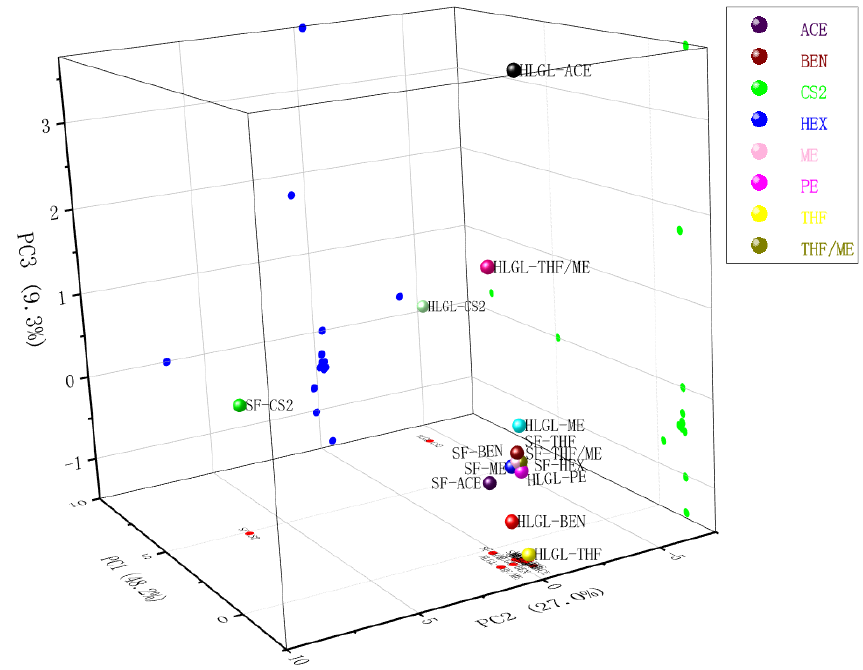
Figure 5. Principal component analysis of the composition of 14 groups of extract families based on GC/MS data.